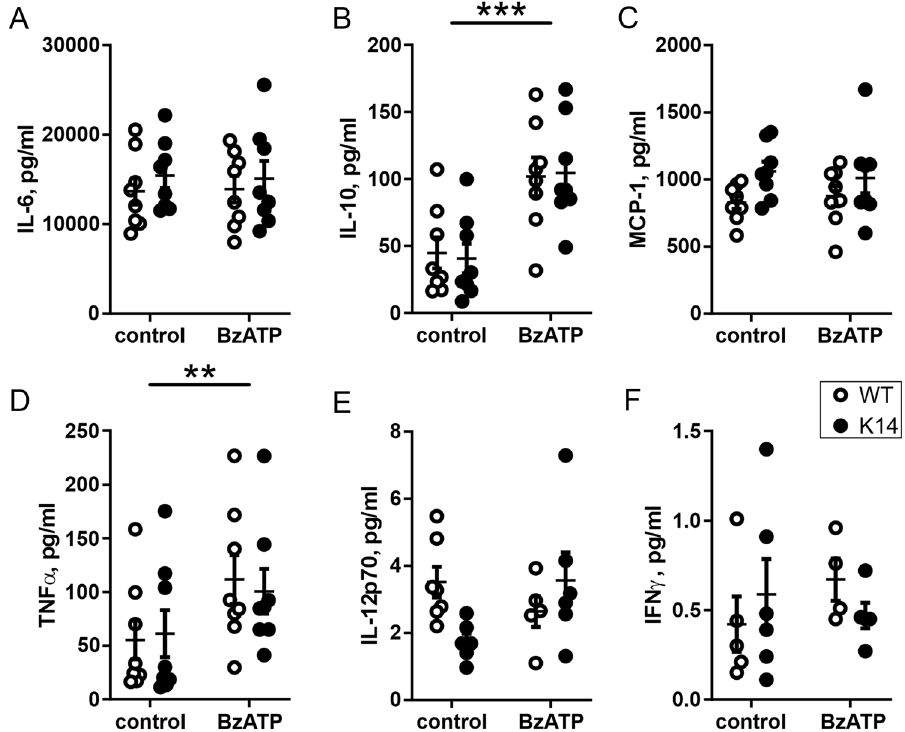
Figure 3. Cytokines release after BzATP stimulation. Scatter plots representing the concentrations of cytokines released from meningeal preparation after stimulation with BzATP: IL-6 ( A ), IL-10 ( B ), MCP-1 ( C ), TNFα ( D ), IL-12p70 ( E ) and IFNγ ( F ). BzATP induced an increase in the release of IL-10 ( B ) and TNFα ( D ) in both the genotypes and post-hoc comparisons revealed no differences in cytokines levels between WT and K14 preparations. Number of replicates for IL-6, IL-10, MCP-1, and TNFα: n = 8/experimental group; for IL-12p70: n = 7/6 (control) and n = 5/6 (BzATP) for WT and K14, respectively; for IFNγ: n = 5/6 (control) and n = 4/5 (BzATP) for WT and K14, respectively. *** p < 0.001 and ** p < 0.01 (treatment effect) by matched two-way ANOVA with Bonferroni post-hoc test.